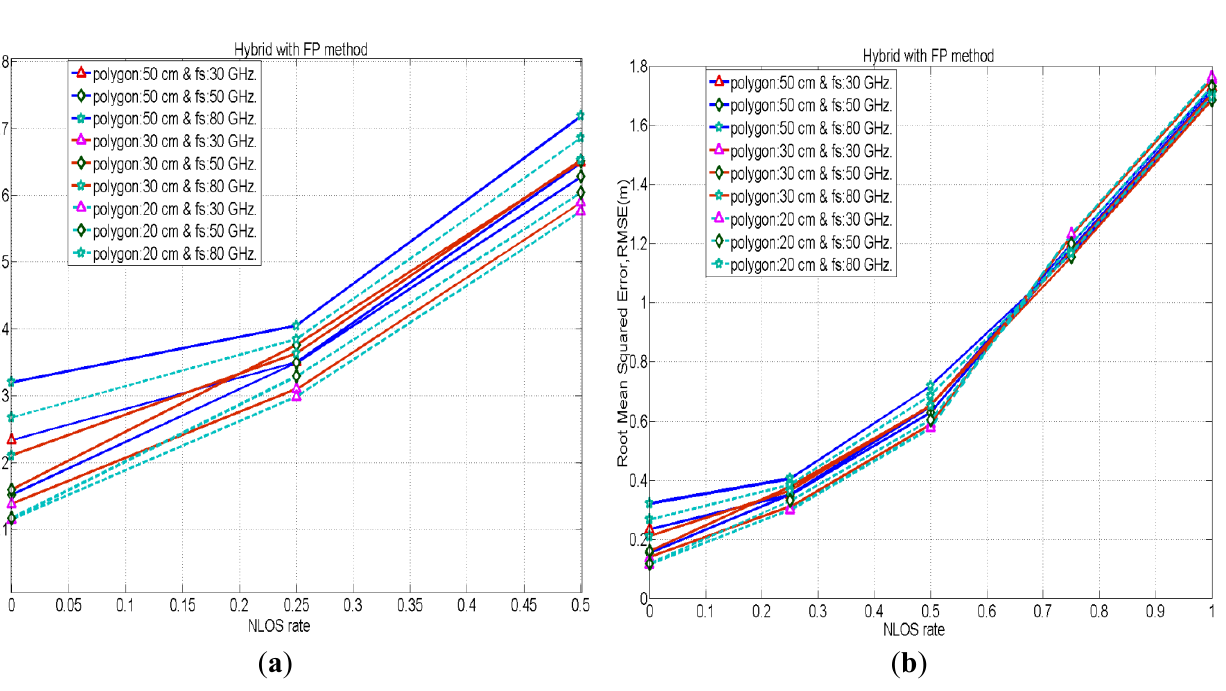
Figure 9. Positioning accuracies in hybrid method for various cases with polygon sizes in LOS and different NLOS